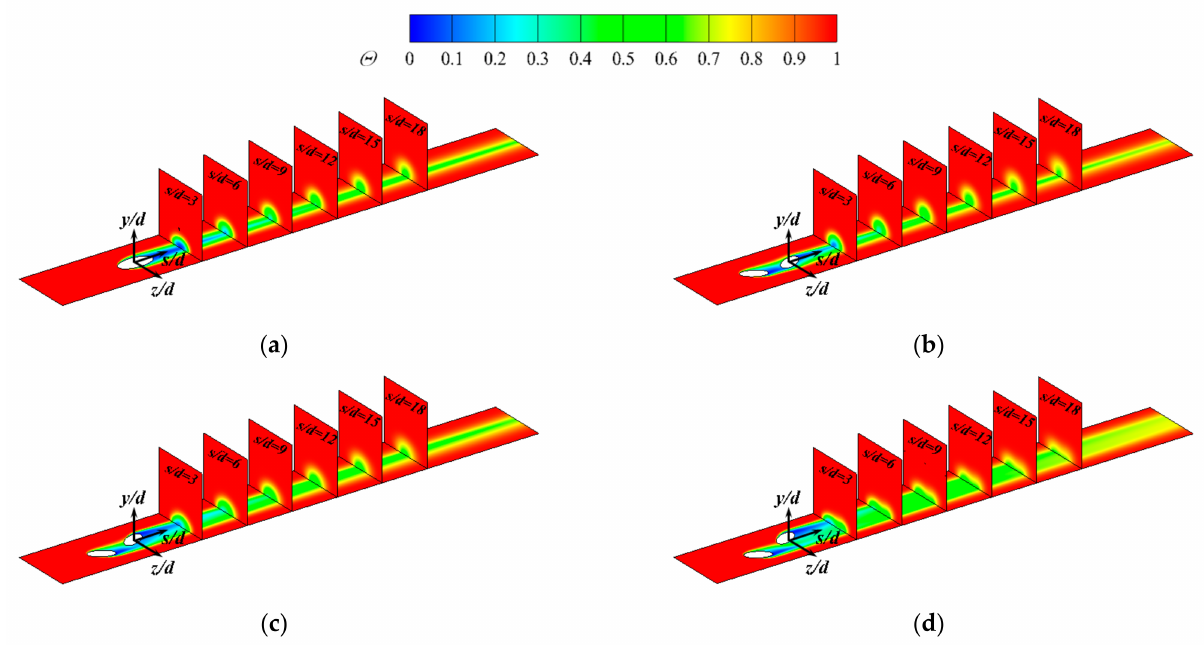
Figure 12. Dimensionless temperature contours in downstream normal sections on the pressure side under M = 0.5. ( a ) cylindrical hole, ( b ) Z / d = 0, β = 29 ◦ , ( c ) Z / d = 0.5, β = 29 ◦ , ( d ) Z / d = 1.0, β = 29 ◦